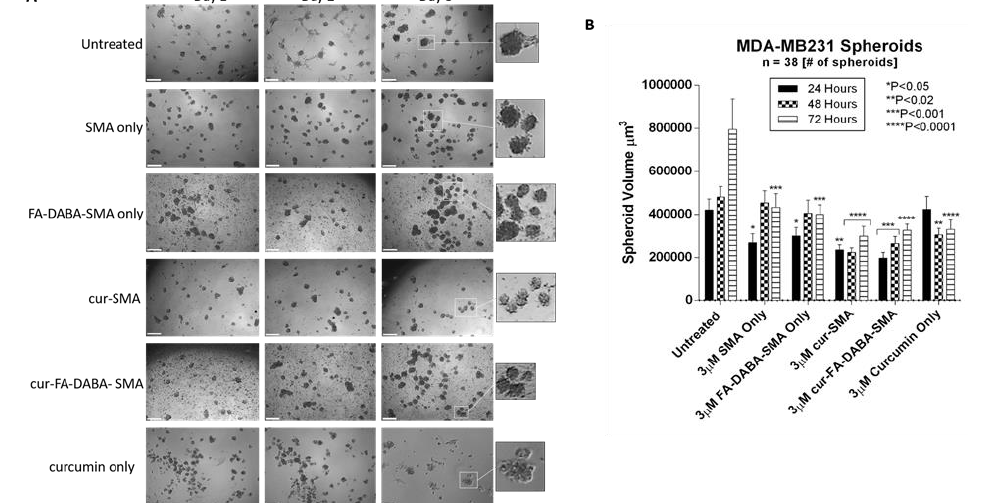
Figure 7. Changes in MDA-MB231 spheroid volume following exposure to 3 µM empty and curcumin loaded SMA and FA-DABA-SMA and 3 µM curcumin only. ( A ) Phase contrast images at 4 ×